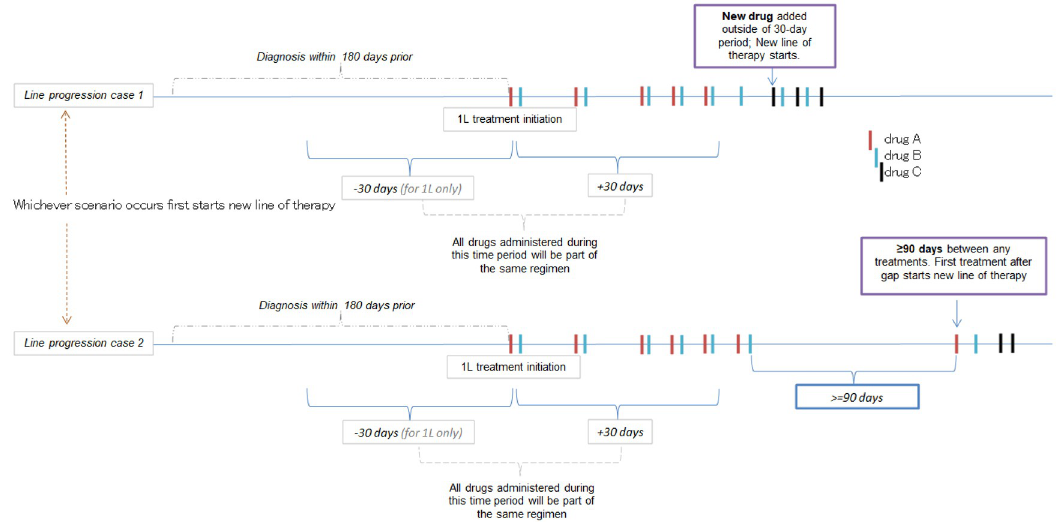
Fig 1. Line of therapy diagram indicating identification of treatment